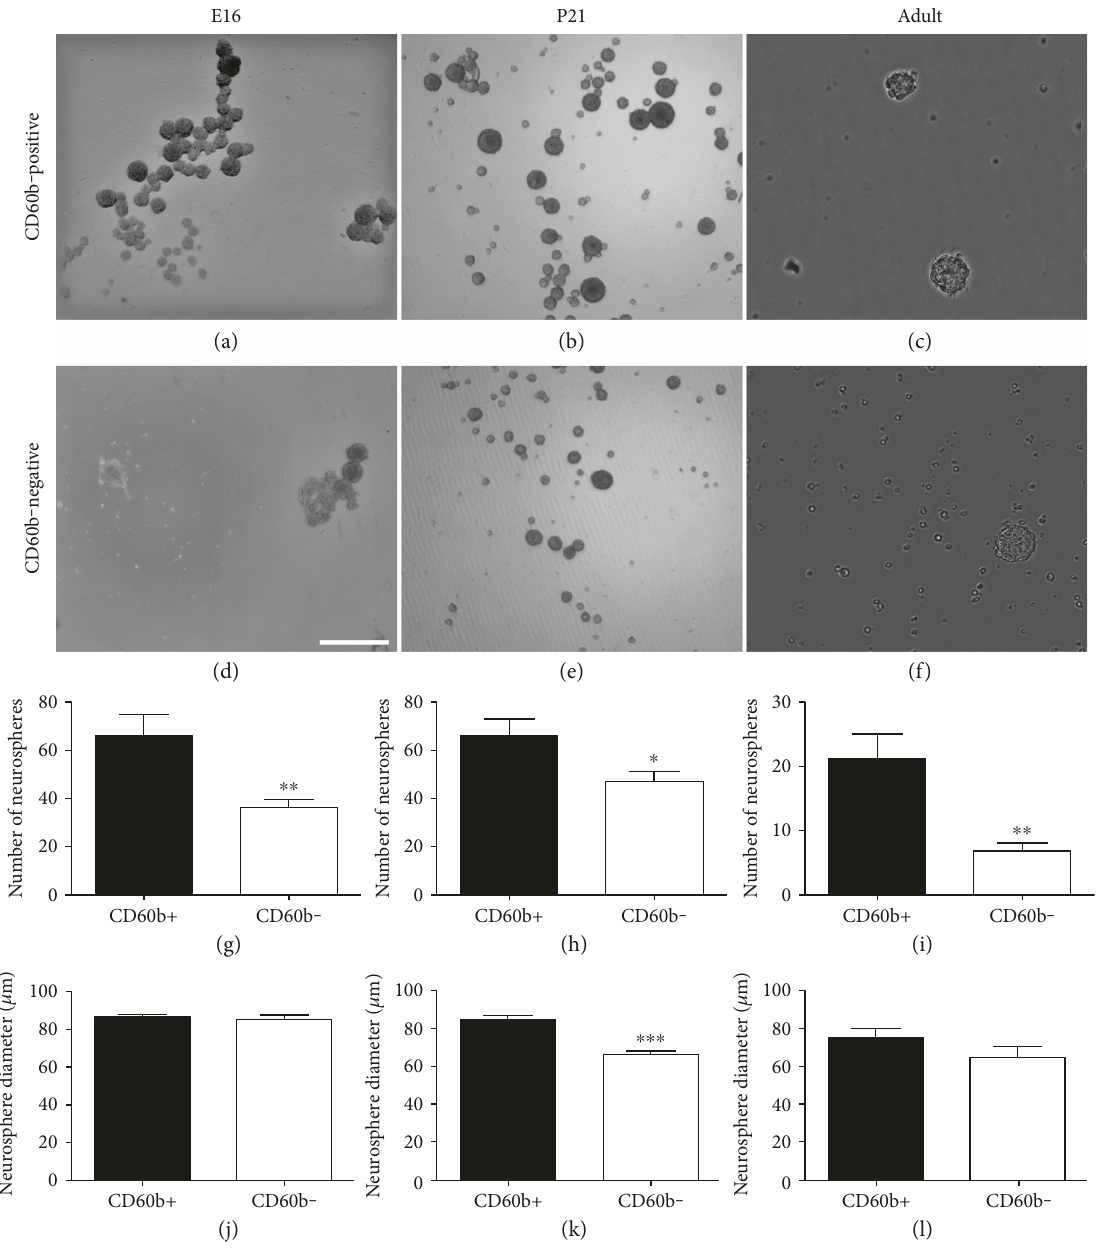
Figure 7: Quanti fi cation of neurospheres derived from CD60b-positive and CD60b-negative cells. (a – c) Neurospheres derived from CD60b- positive cells from E16 (a), P21 (b), and adult (c) rats. (d – f) Neurospheres derived from CD60b-negative cells in E16 (d), P21 (e), and adult (f) rats. (g – i) Quanti fi cation of the number of neurospheres derived from CD60b-positive and CD60b-negative cells in E16 (g), P21 (h), and